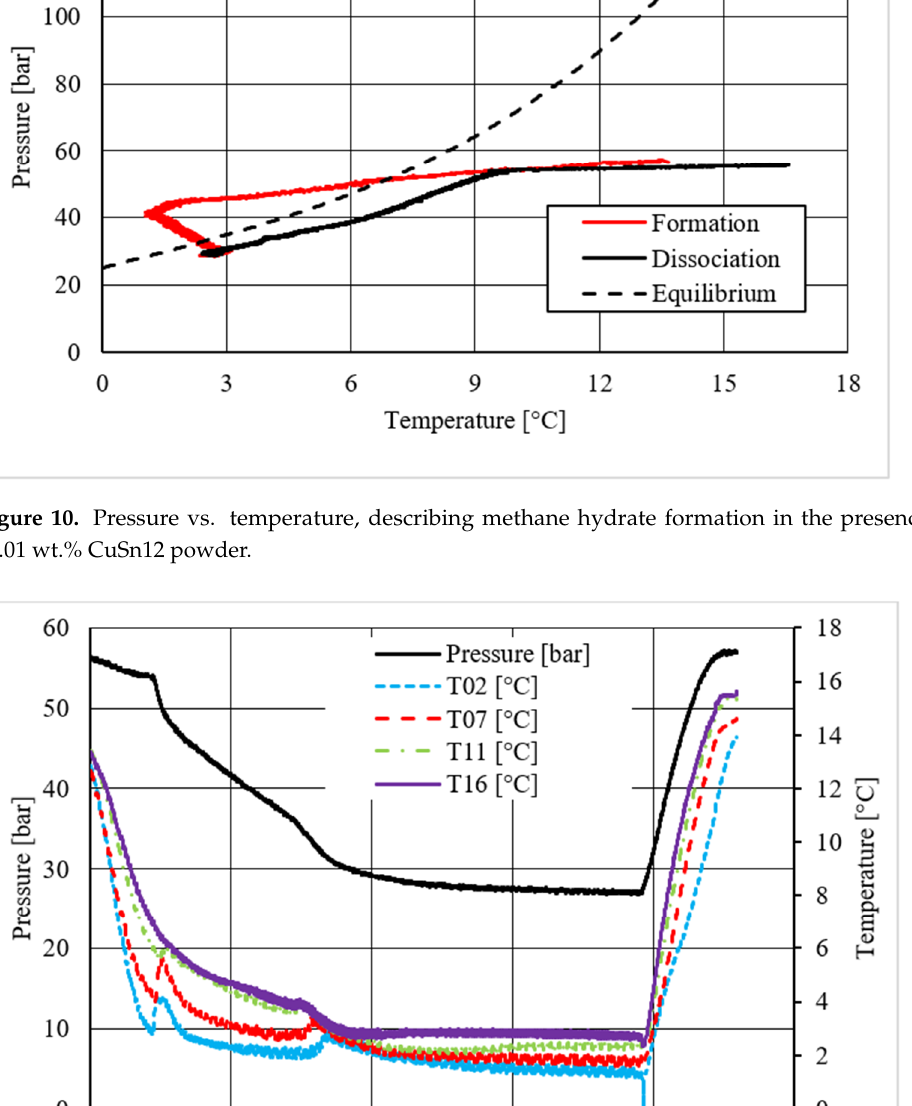
Figure 11. Pressure and temperature trends over time, measured for methane hydrate formation in the presence of 30.66 wt.% CuSn12 powder.